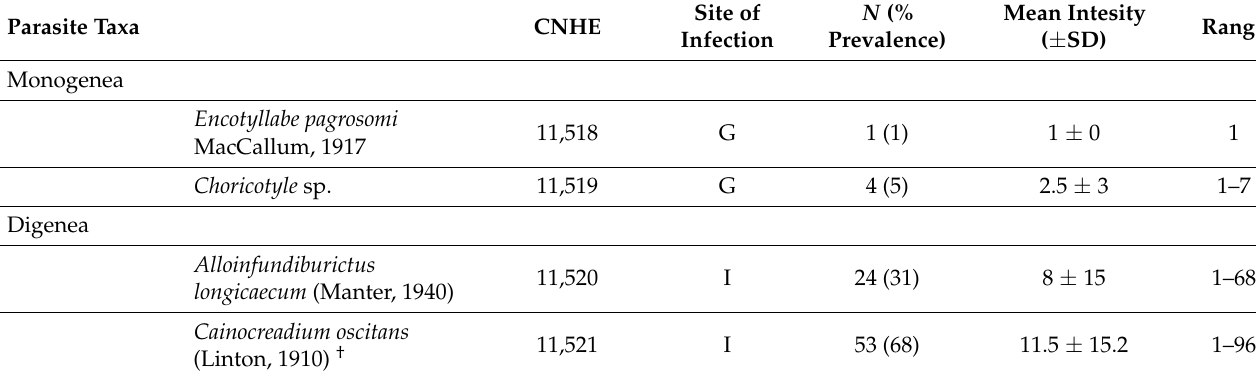
Table 1. Prevalence, mean intensity and site of infection of helminth parasites of 78 Anisotremus surinamensis from reefs of the PNSAV, Veracruz, Mexico. All nine helminths are new host records for A . surinamensis ; † , new geographic record Southern Gulf of Mexico; CNHE, number of catalog of voucher specimens deposited in the Colecci ó n Nacional de Helmintos, UNAM. Sites of infection: I, intestine; G, gills. N , number of hosts infected; P ,